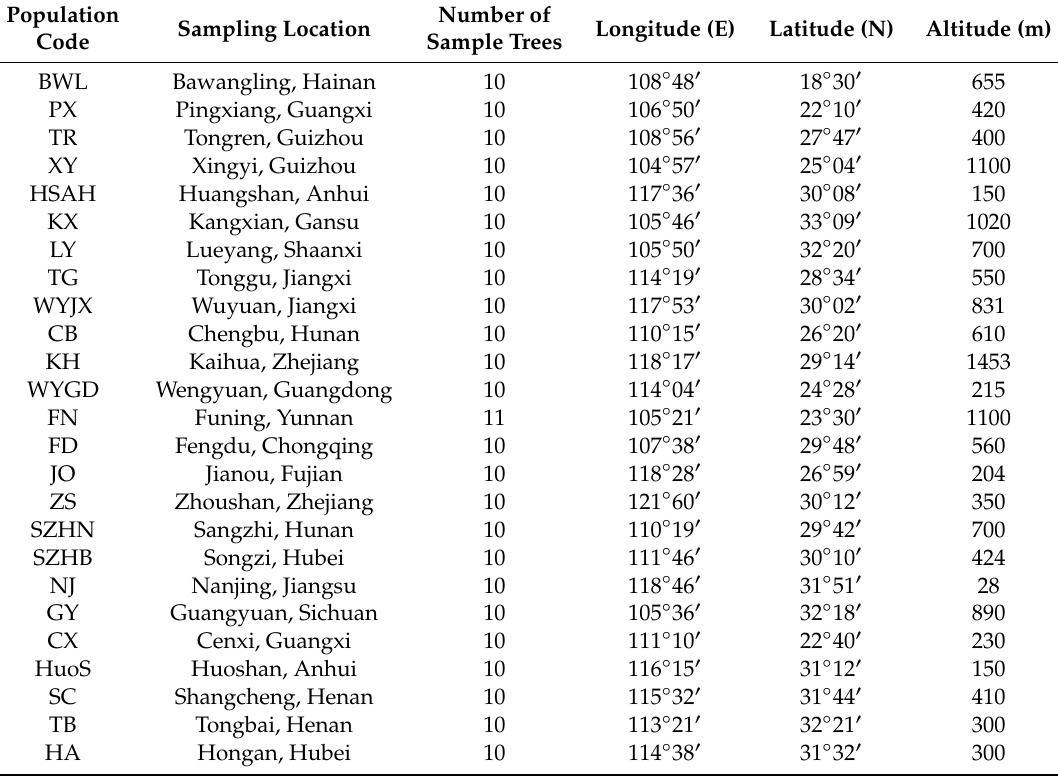
Table 1. Sampling information of Liquidambar formosana